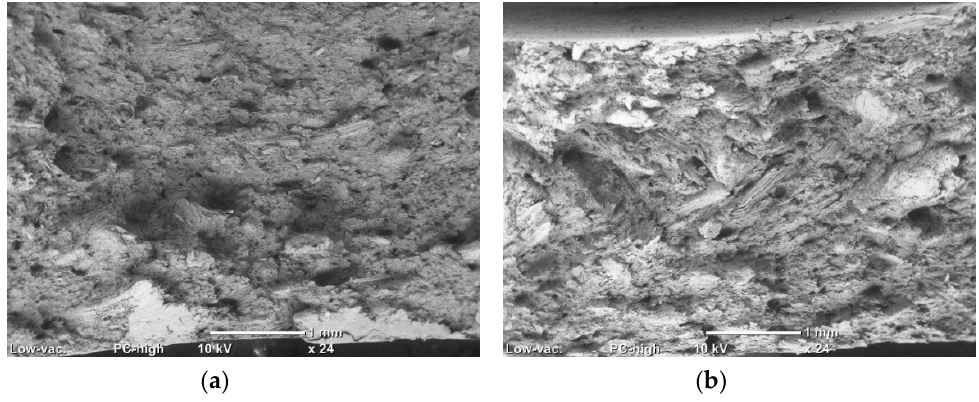
Figure 4. SEM images of the impact fracture surface of: ( a ) 40 WPC; and ( b ) 40WPC7.5.